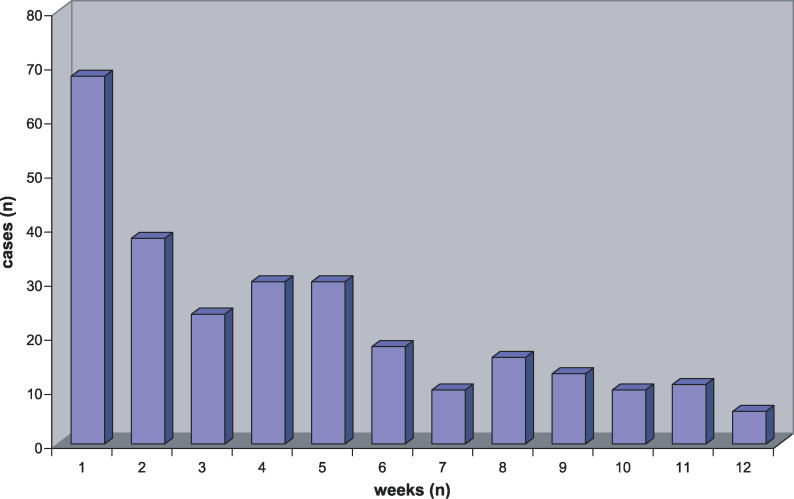
Frequency of the Occurrence of Events within the First 12 wk after TravelThe time window of analysis concerned the first 8 wk.